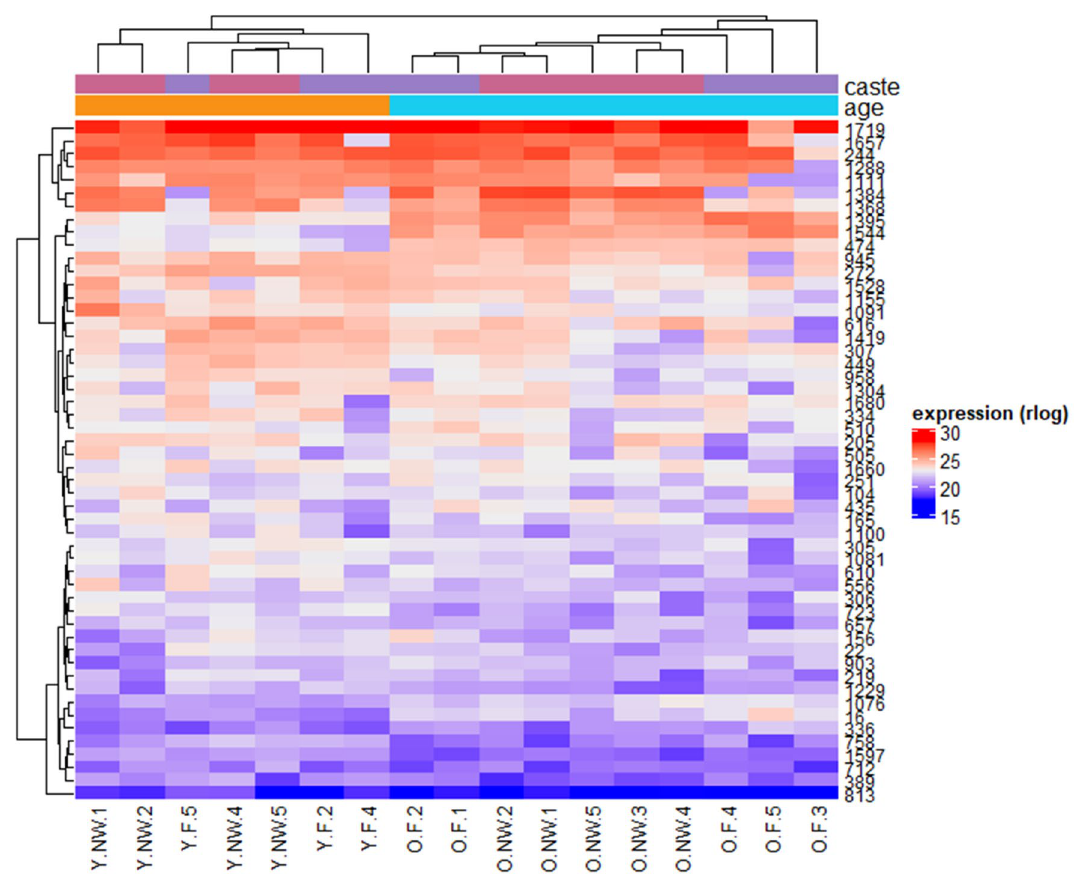
Figure 2. Heat map of the 50 most expressed proteins amongst our four experimental groups in of workers of Lasius niger . At the top, colours indicate the age (orange: young, light blue: old) and caste (pink: nest workers, purple: foragers). At the bottom are the sample identifiers (F: forager, NW: nest worker, Y: young, O: old). Protein IDs are given in the right-hand column. Correspondence between ID and name is indicated in every table provided. All proteins have an FDR < 0.05 and |fold-change| >